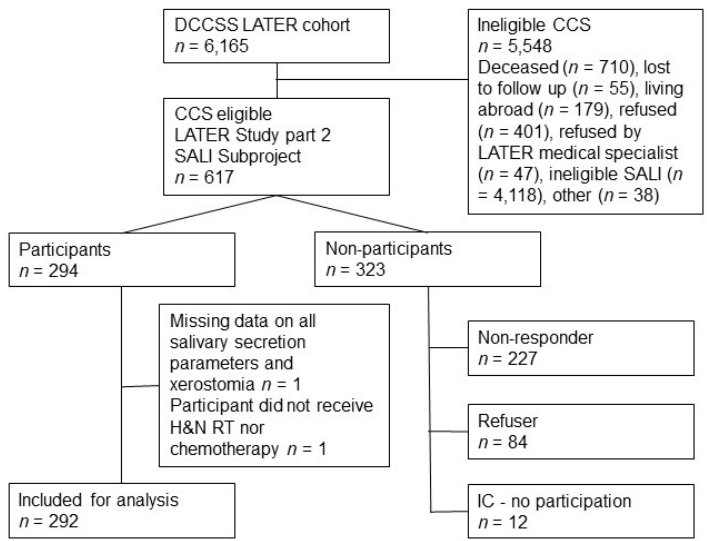
Figure 1. Flowchart of the DCCSS LATER 2 SALI study inclusion process. DCCSS LATER; Dutch Childhood Cancer Survivor Study Late Effects Study, IC—no participation; survivors signed informed consent for participation, however, data collection was hampered for different reasons. CCS who were ineligible for the SALI subproject were treated in outpatient clinics of DCCSS LATER 2, which were not participating in the SALI subproject. Table 2. Applied radiation fields and dose of radiation (in Gy) in the group of CCS treated with H&N RT. Radiation